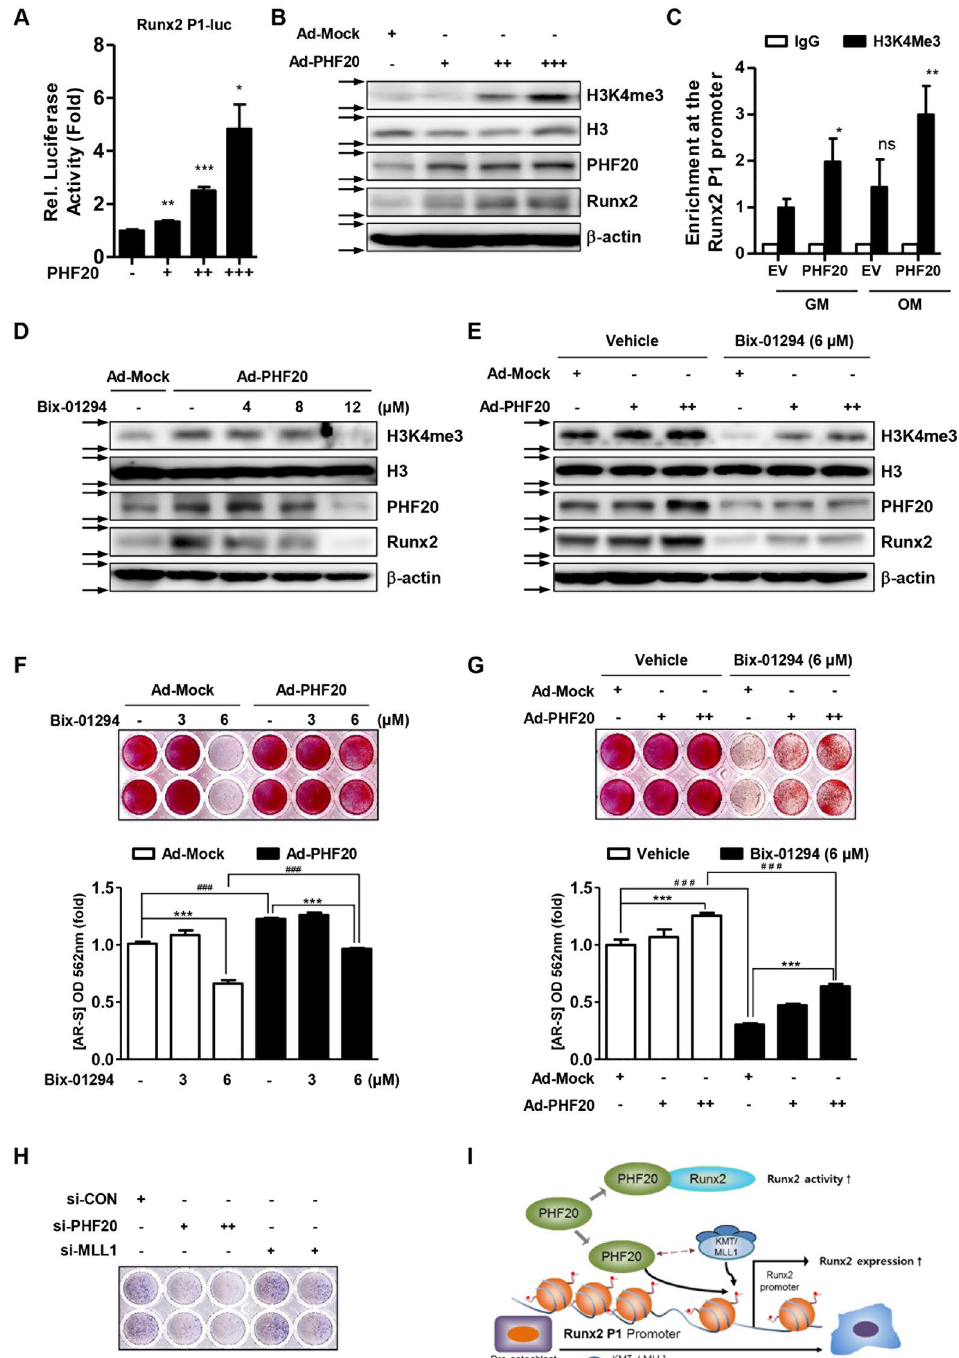
Figure 5. PHF20 increases enrichment of H3K4me3 at the P1 promoter of Runx2 accompanied by Runx2 expression. ( A ) Effects of PHF20 on luciferase activity of P1 Promoter of Runx2. MC3T3-E1 cells were co- transfected with Runx2-756-P1-Luc (200 ng) and PHF20 expression vectors ( + , 100 ng; ++ , 200 ng; +++ , 300 ng). Values are means ± SEM (n = 3). * p < 0.05, ** p < 0.01 and *** p < 0.001 compared to the control. ( B ) Effects of PHF20 on H3K4me3 levels. MC3T3-E1 cells were infected by Ad-GFP ( + , 50 MOI) as a mock, Ad-PHF20 ( + , 20 MOI; ++ , 50 MOI; +++ , 100 MOI), and then Western blot analysis was performed. ( C ) Chromatin immunoprecipitation (ChIP) analysis of the recruitment of H3K4me3 to Runx2-756-P1 promoter region. Transfected whole cell lysates were precipitated using antibodies against H3K4me3 or IgG. PCR was performed to quantify binding of the 500 bp of the P1 promoter of Runx2 to H3K4me3. IgG was used as a specificity control. Values are means ± SEM (n = 3). * p < 0.05 and ** p < 0.01 compared to cells transfected with empty vector (E.V). ( D , E ) Combinatory effects of Bix-01294 and PHF20 overexpression on H3K4me3 and Runx2 protein levels. Cells were treated with treatment of Ad-Mock (50 MOI) and Ad-PHF20 (100 MOI) for 24 hours followed by the indicated amount of Bix-01294 treatment for 72 hours. Arrows ( → )